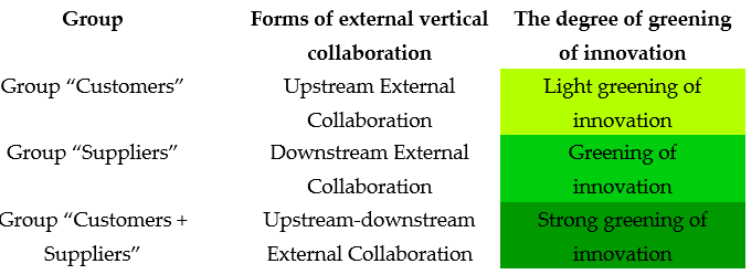
Figure 9. The level of the greening of innovation depends on the subjective scope of cooperation in the supply chain.